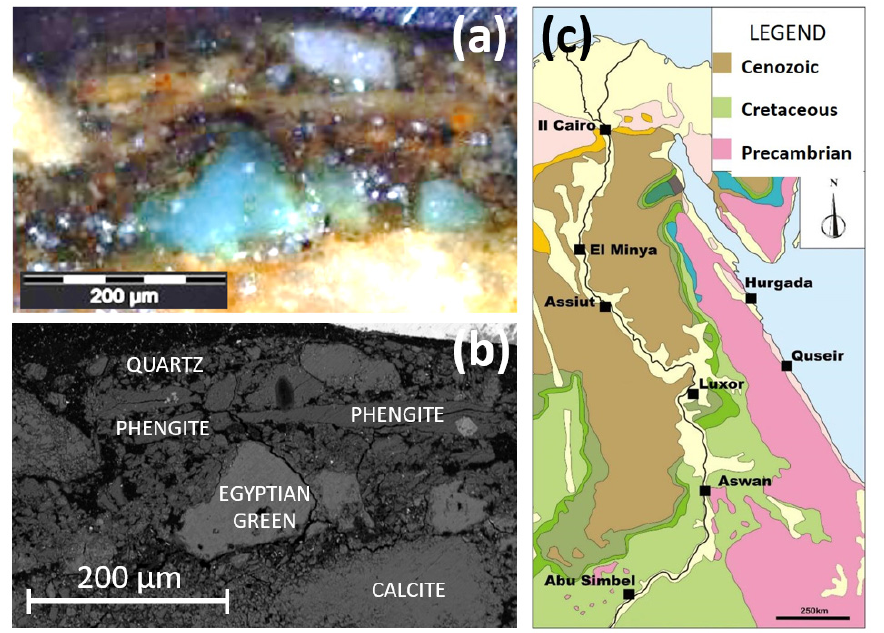
Figure 10. OM ( a ) and SEM-BS ( b ) images of the surface layer that is composed by an organic material in which different minerals are dispersed; simplified geological map of Egypt ( c ).